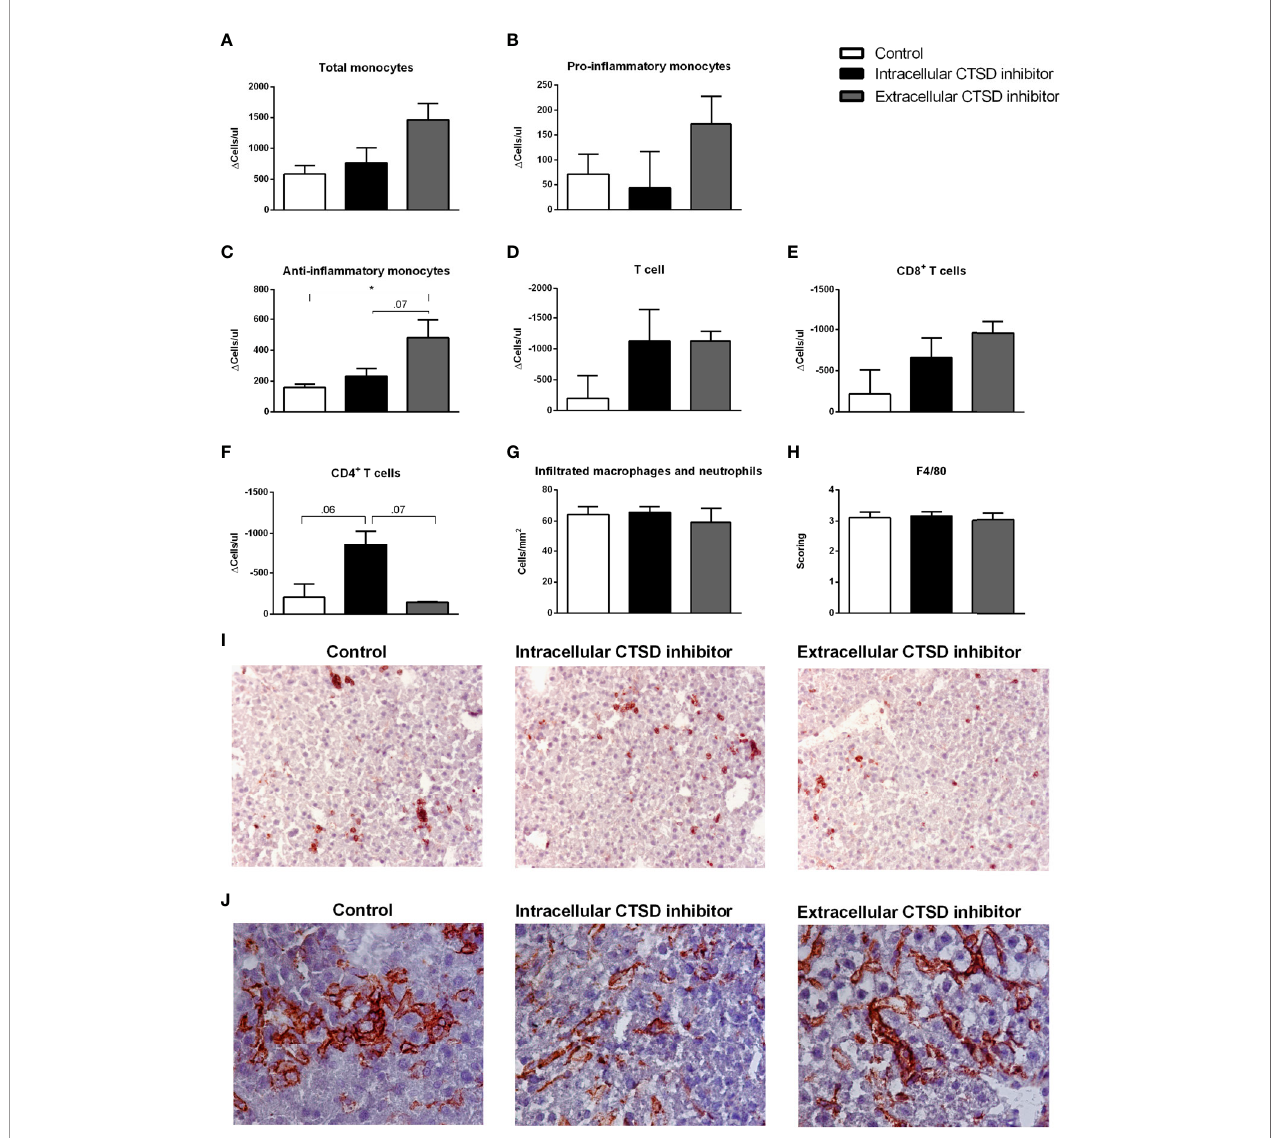
FIGURE 4 | Reduction in in fl ammatory status upon extracellular CTSD inhibition in Ldlr-/- mice: (A – F) Total number of monocyte and T- cell population as measured by FACS. (G) Liver sections were stained for in fi ltrating macrophages and neutrophil cells (Mac-1). Positive cells were counted in six microscopical views. (H) Immunostaining of livers for F4/80. Positive cells were scored assessed and given a score in arbitrary units (A.U.) (I) Representative pictures of Mac-1 staining (original magni fi cation, 200x) and (J) F4/80 (original magni fi cation, 400x). Error bars represent SEM; n = 5 per each group for FACS and n = 3 per group for proteomics; * represents p < 0.05 compared to control mice as determined by one-way